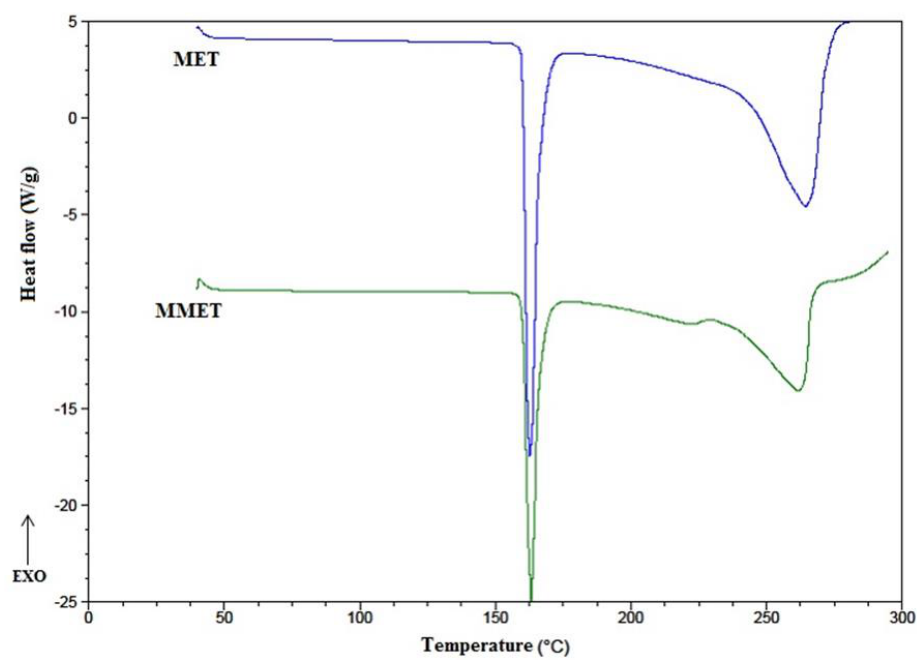
Figure 1. DSC thermographs of unmilled metronidazole (MET) and metronidazole milled for 30 min at 20 Hz (MMET).